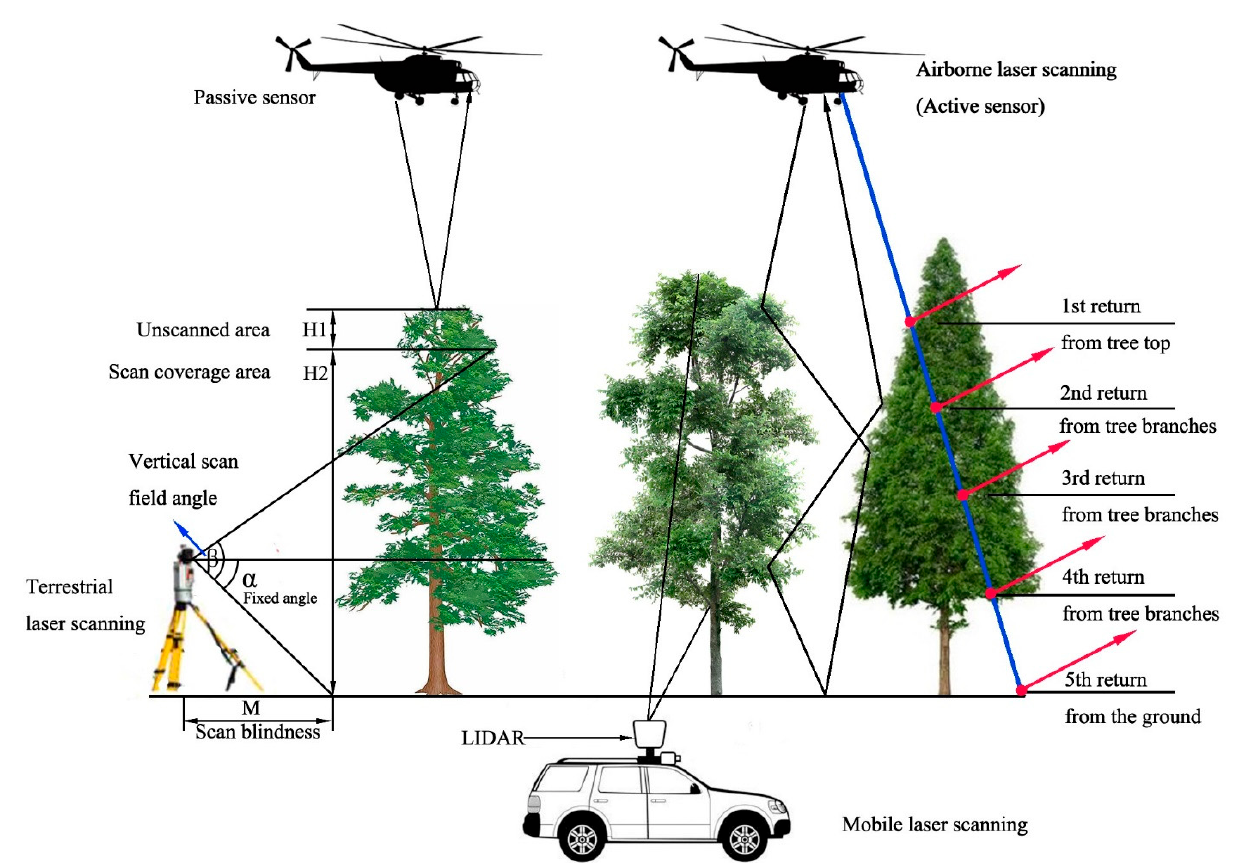
Figure 2. Data acquisition principles of airborne laser scanning (ALS), terrestrial laser scanning (TLS), and mobile laser scanning (MLS) on urban forests. The red arrows represent multiple returns from a single laser pulse.